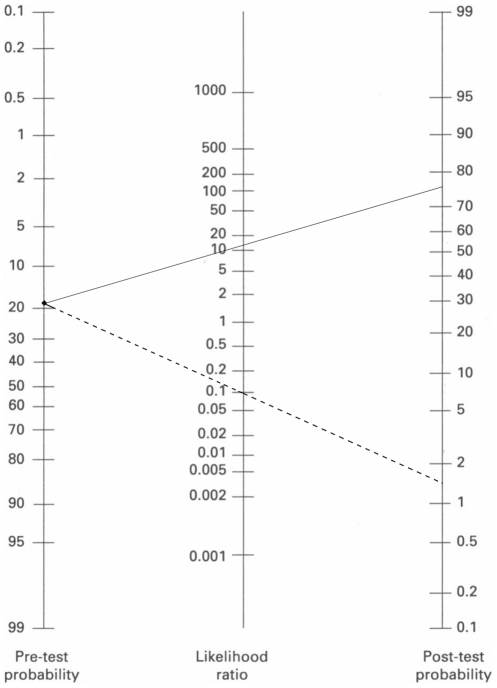
Fagan's nomogram for calculating posttest probabilities (PTPs).A straight edge was used to link the pretest probability of IA with the PTP, by crossing the likelihood ratio line at a point that describes the results obtained. The solid line extends from the prevalence to the PLR; the dotted line extends from the prevalence to the NLR.